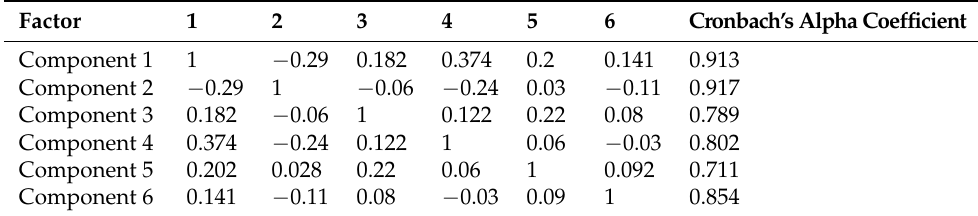
Table 6. Component Correlation Matrix and Reliability of the